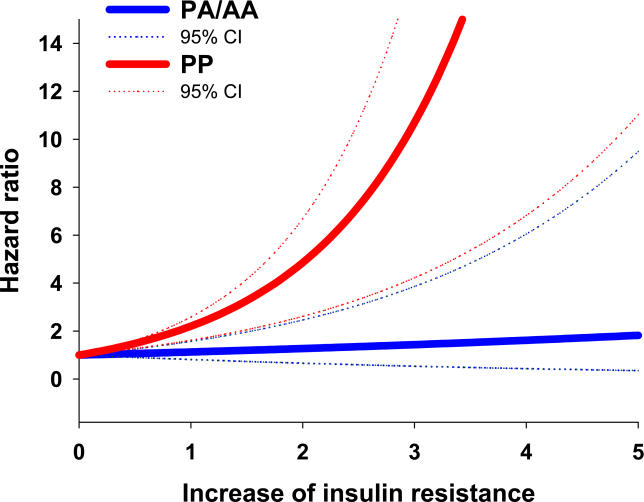
The Effect of Insulin Resistance Together with the Risk Genotype of the PPARG P12A Polymorphism on Risk of Developing T2D
y-Axis denotes HR and its 95% CI. x-Axis denotes increase in insulin resistance estimated as HOMAIR.